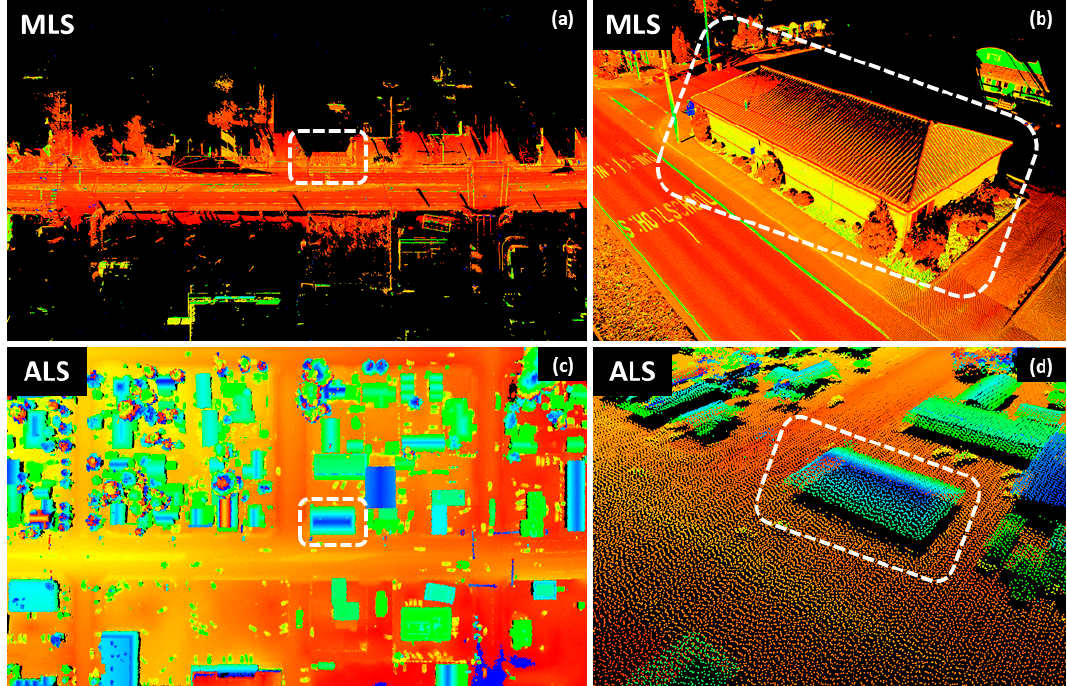
Figure 1. Comparison between MLS ( a ) and ALS ( c ) data for the same area of interest showing a close-up of a building ( b ) for MLS and ( d ) ALS.